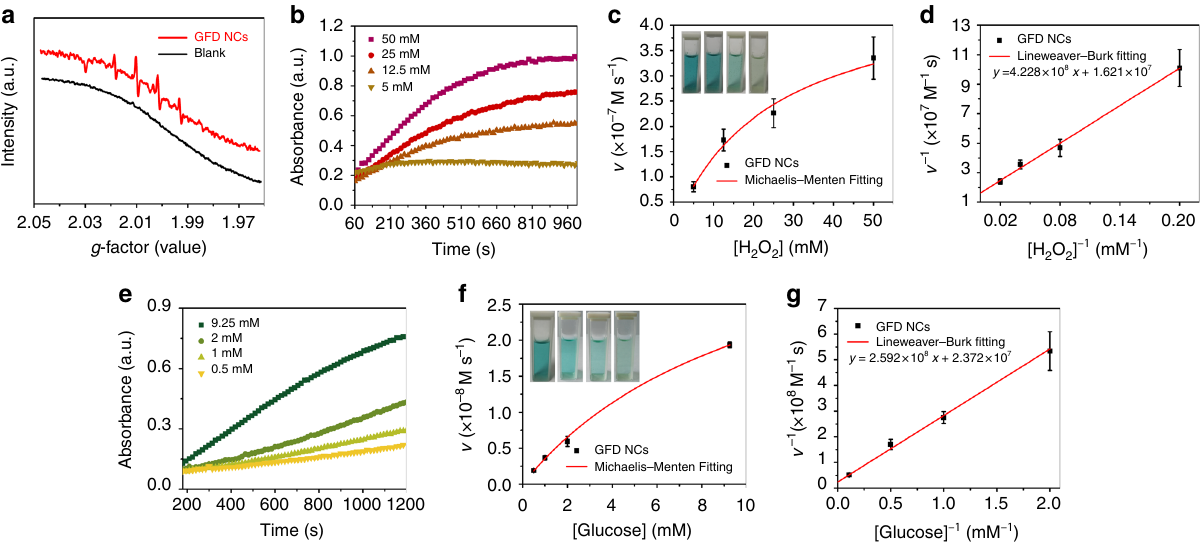
Fig. 3 In vitro characterizations of the catalytic performances of sequential GFD NCs. a ESR spectra of GFD NCs (10 μ g ml − 1 ) with or without the addition 10 mM glucose. Michaelis – Menten steady-state kinetics of ( b – d ) Fe 3 O 4 NPs and ( e – g ) sequential GOD-Fe 3 O 4 NPs con fi ned in GFD NCs. Time-course absorbance of GFD NCs upon the addition of varied concentrations of ( b ) H 2 O 2 (50, 25, 12.5, and 5 mM) or ( e ) β - D -glucose (9.25, 2, 1, and 0.5 mM). Michaelis – Menten kinetics and Lineweaver – Burk plotting of ( c ), ( d ) Fe 3 O 4 NPs and ( f ), ( g ) sequential GOD-Fe 3 O 4 NPs con fi ned within the mesopores of DMSN. Mean values and error bars are de fi ned as mean and s.d., respectively. The initial velocities were calculated in eight periods (15 s per period) in